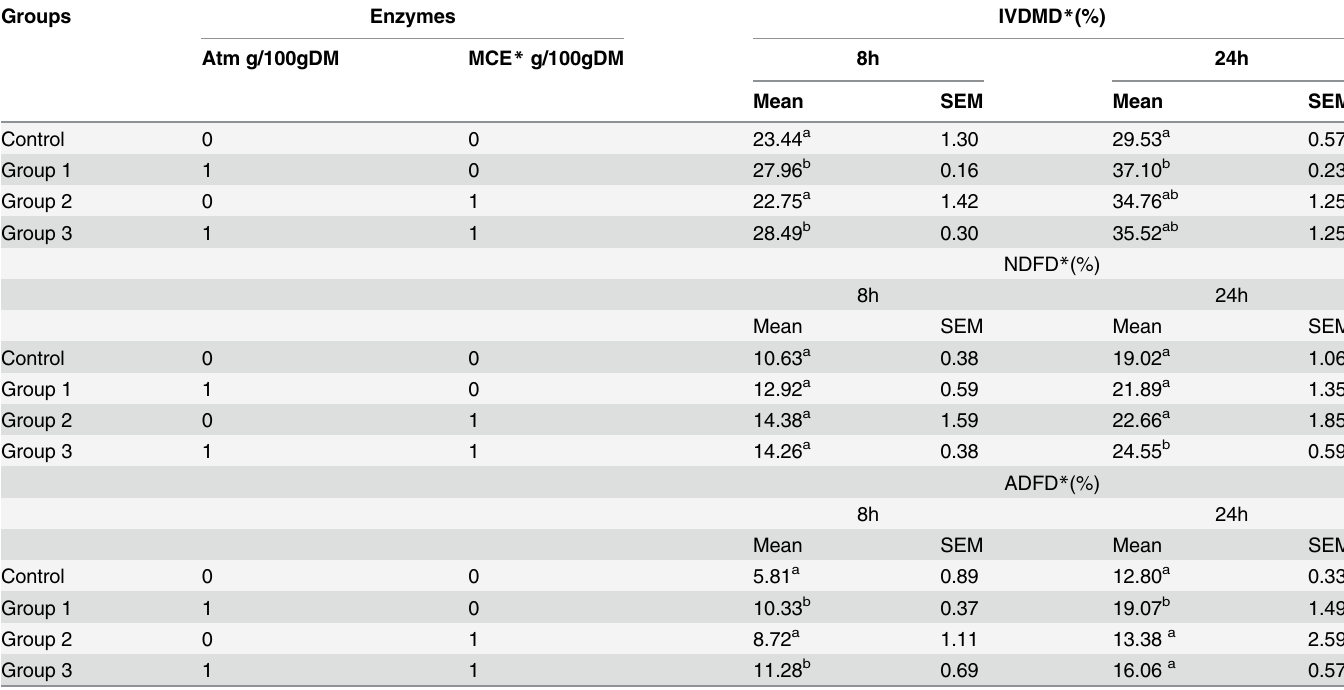
Table 2. Effects of laccase Atm and/or fibrolytic compound enzymes on ruminal digestibility in vitro .